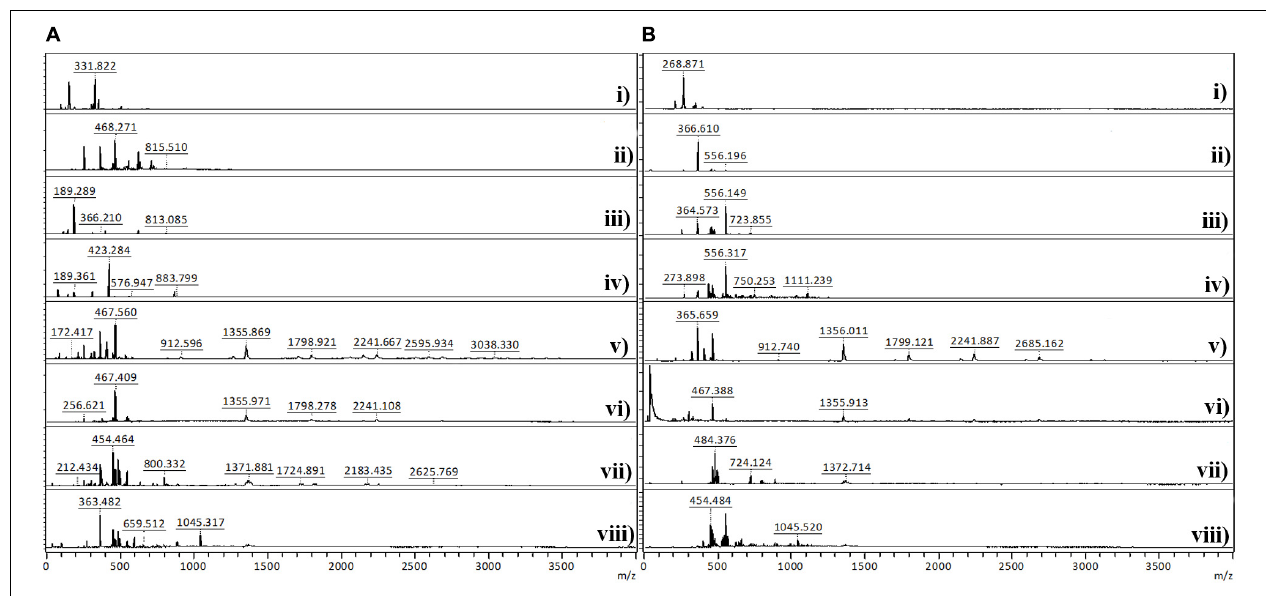
FIGURE 4 | MALDI-TOF analysis of polyaniline obtained after in situ reaction on BC under different conditions in the absence (A) and in the presence of CMC (B). (A) : (i) aniline; (ii) aniline + laccase; (iii) aniline + KHCF; (iv) aniline + KHCF + laccase; (v) aniline + AOT; (vi) aniline + AOT + laccase; (vii) aniline + KHCF + AOT; (viii) aniline + KHCF + AOT + laccase; (B) : (i) aniline + CMC; (ii) aniline + laccase + CMC; (iii) aniline + KHCF + CMC; (iv) aniline + KHCF + laccase + CMC; (v) aniline + AOT + CMC; (vi) aniline + AOT + laccase + CMC; (vii) aniline + KHCF + AOT + CMC; (viii) aniline + KHCF + AOT + laccase + CMC.